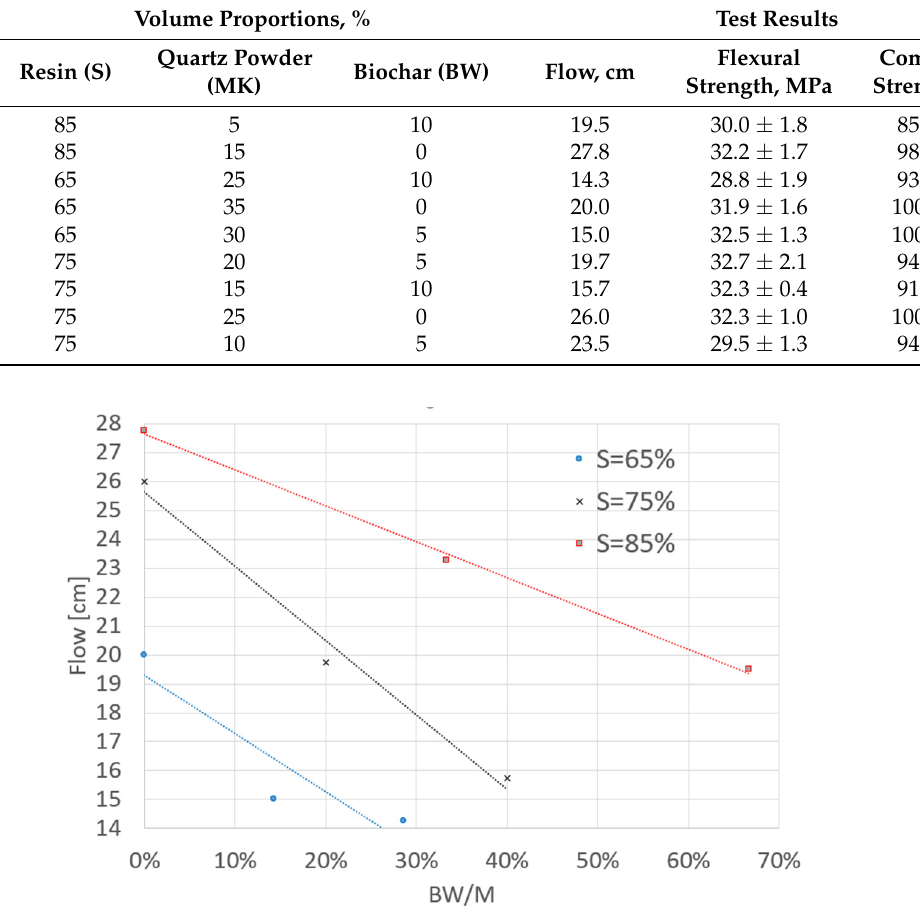
Figure 6. Flow of a fresh composite as a measure of workability as a function of the level of biochar content and the level of polymer content. Table 4. The result of consistency, flexural and compressive strength.